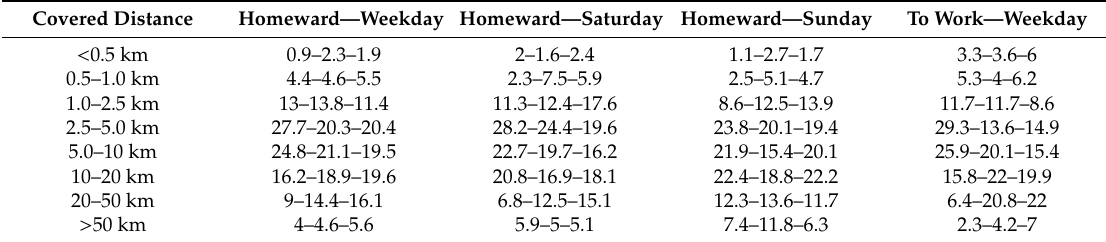
Table A3. Share of trips in % according to the covered distance depending on the EV user group, weekday and grid region (urban–suburban–rural) [66].